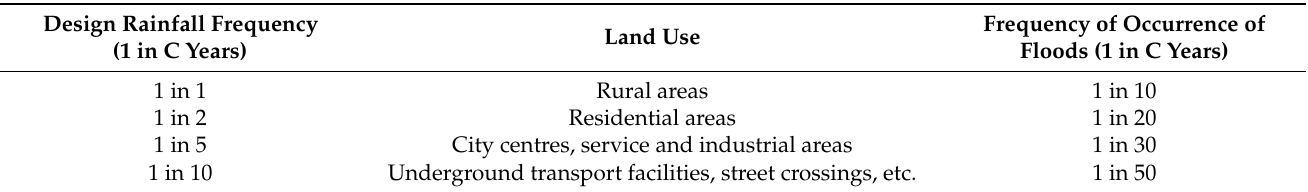
Table 1. Computational rainfall and flood